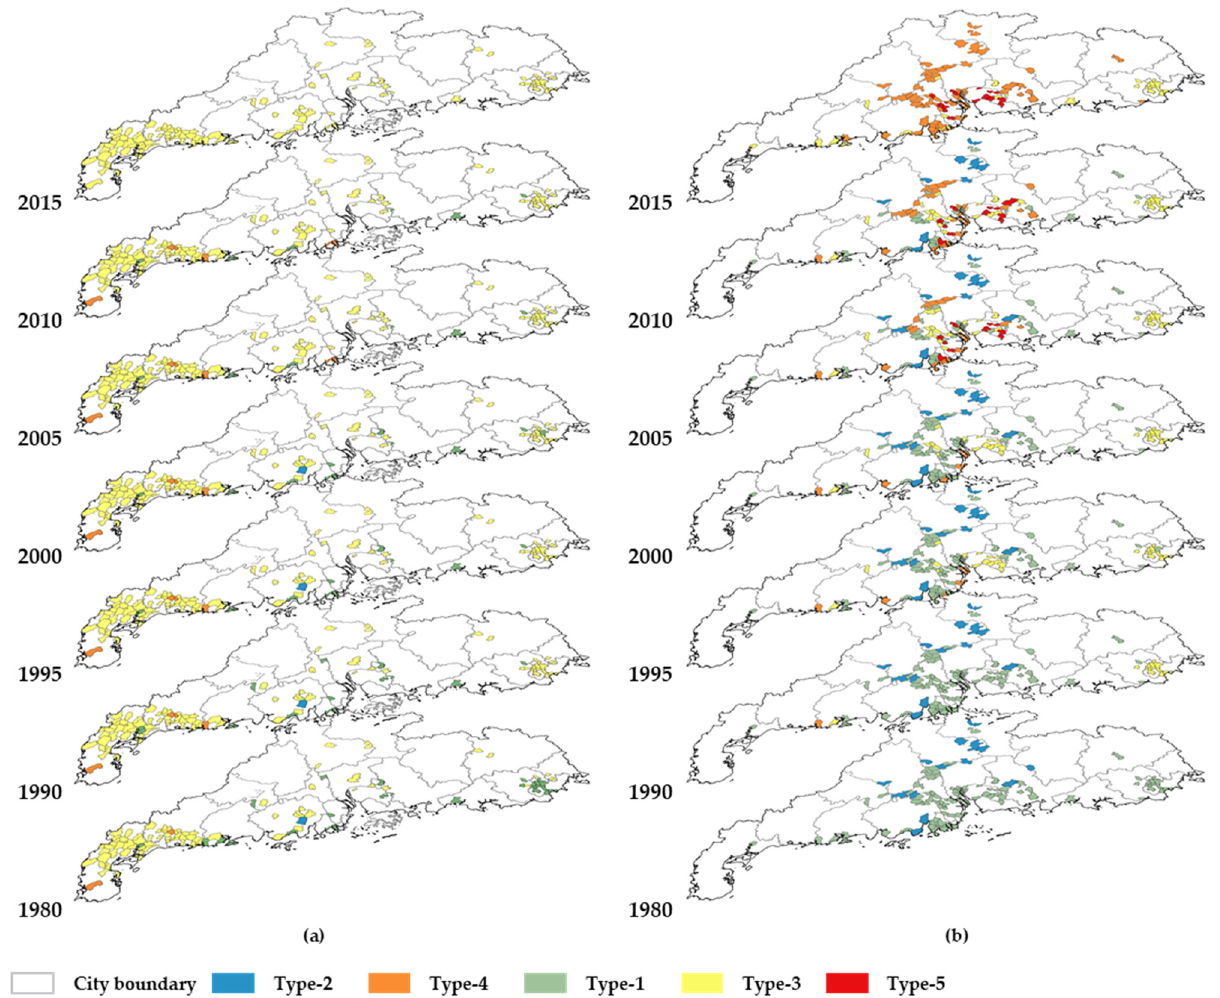
Figure 4. ( a ) Land use change sequences/trajectories (from 1980–2015) of the urbanized RTSs (i.e., Type-4 and Type-5) in 2015; ( b ) land use change sequences/trajectories (from 1980–2015) of the agricultural upgraded RTSs (i.e., Type-3) in 2015.